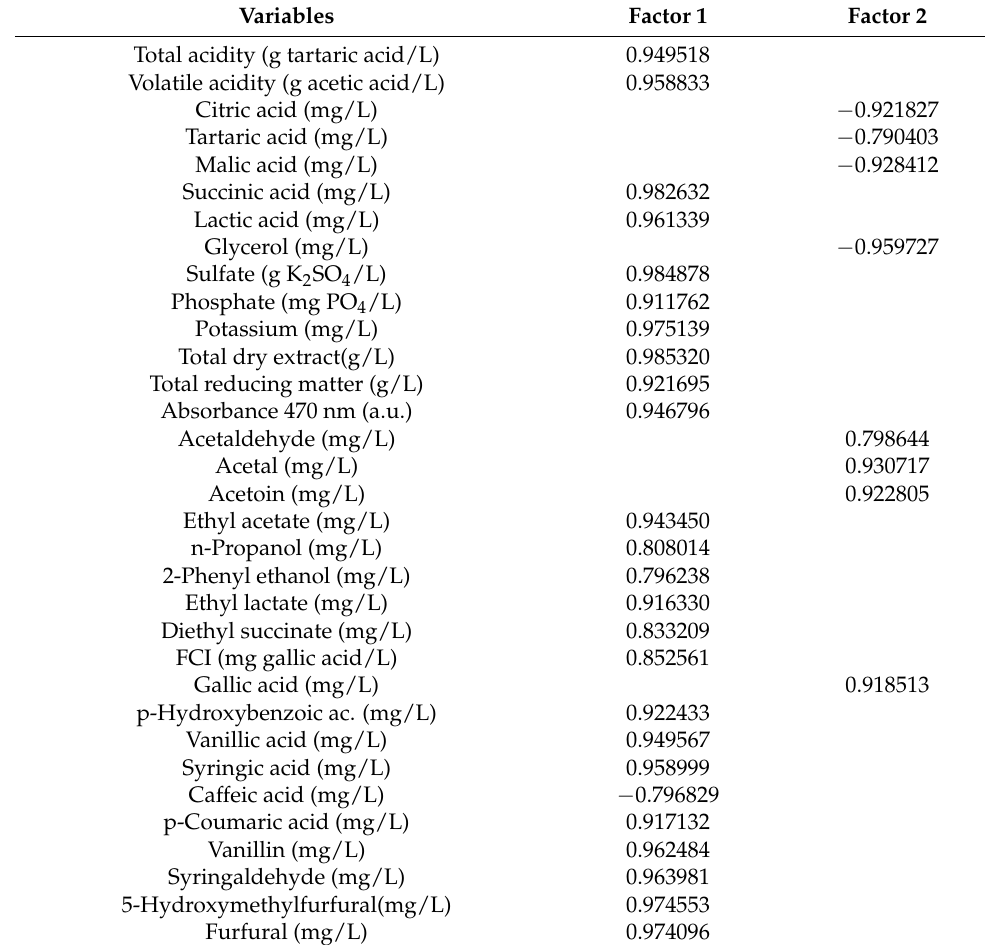
Table 9. Coefficients of Factors 1 and 2 after varimax rotation of the variables that have shown the highest correlation (r >